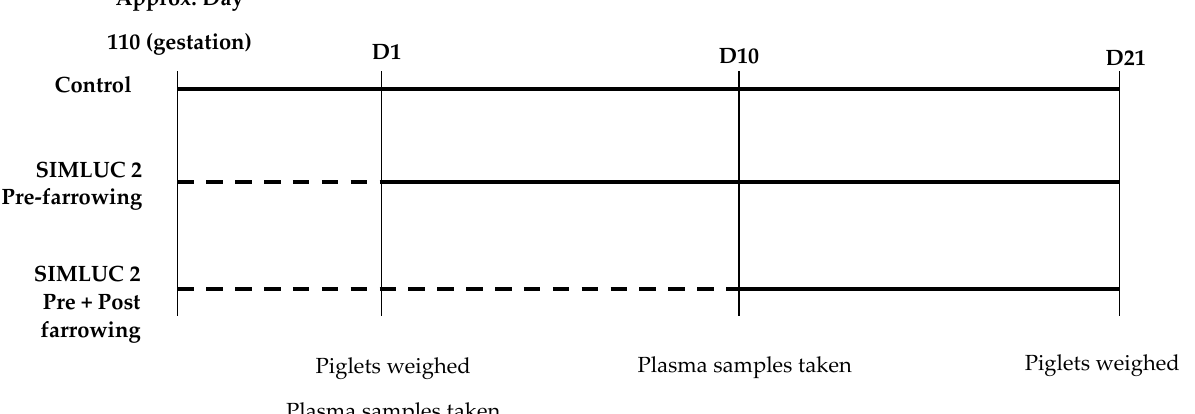
Figure 1. Timeline of diets and measurements taken at day 1 (D1), day 10 (D10), and day 21 (D21) after farrowing. Dashed line indicates feeding of SIMLUC 2 and solid line CON diets.